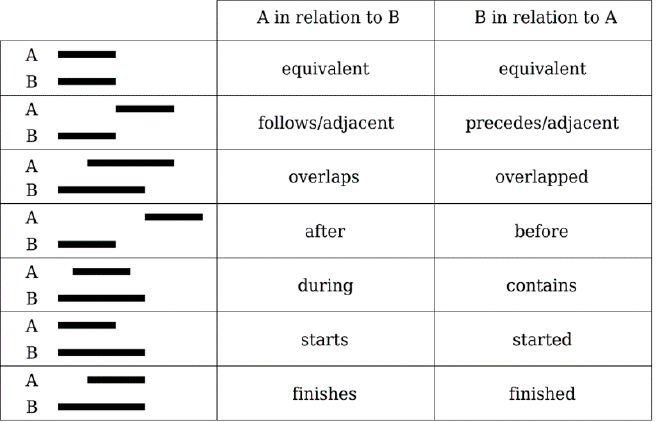
Figure 8. The Allen temporal topology schema, simplified by [52] and implemented in TGRASS. Reproduced with permission from Gebbert, S. and E. Pebesma, A temporal GIS for field based environmental modeling. Env. Modelling & Software ; published by Elsevier, 2014.